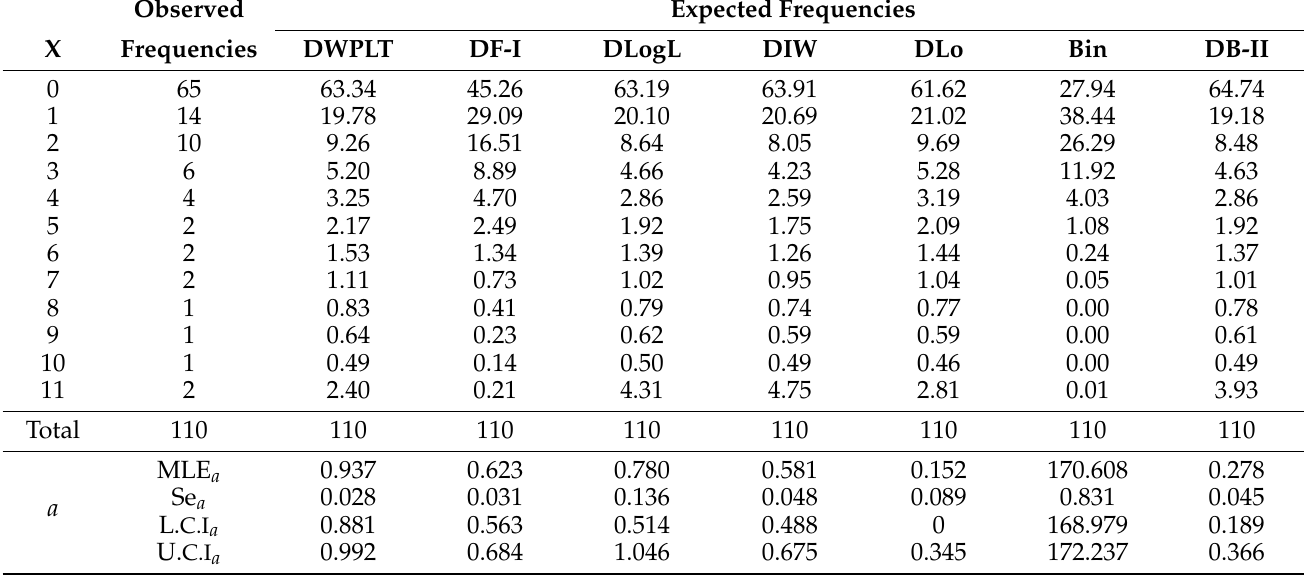
Table 4. GOFM for the dataset—Part